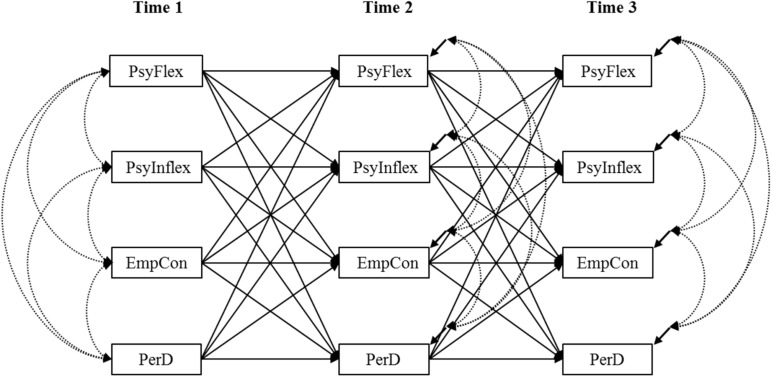
Longitudinal path.